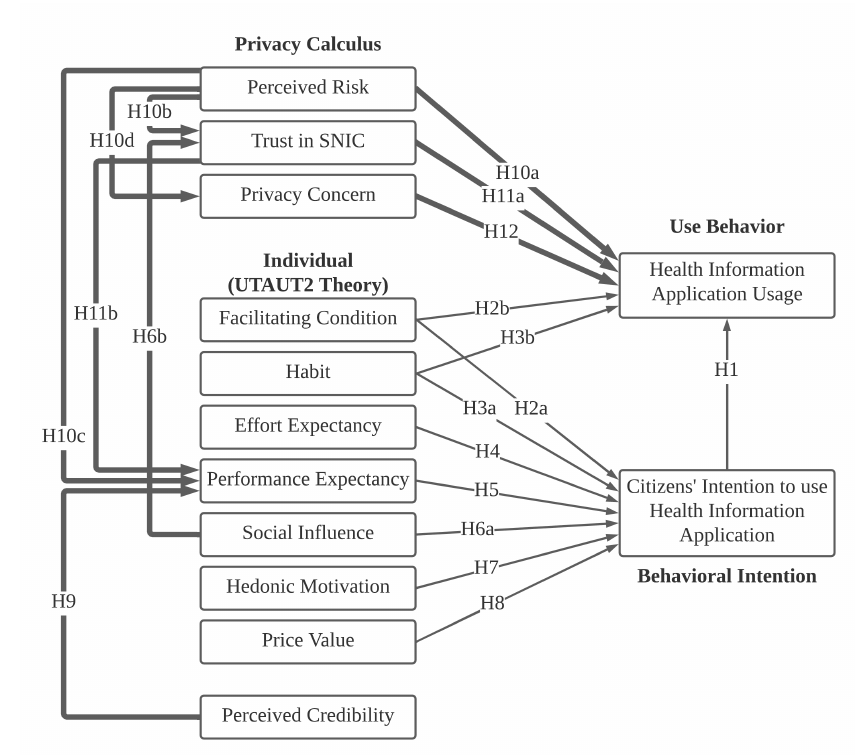
Figure 1. Research